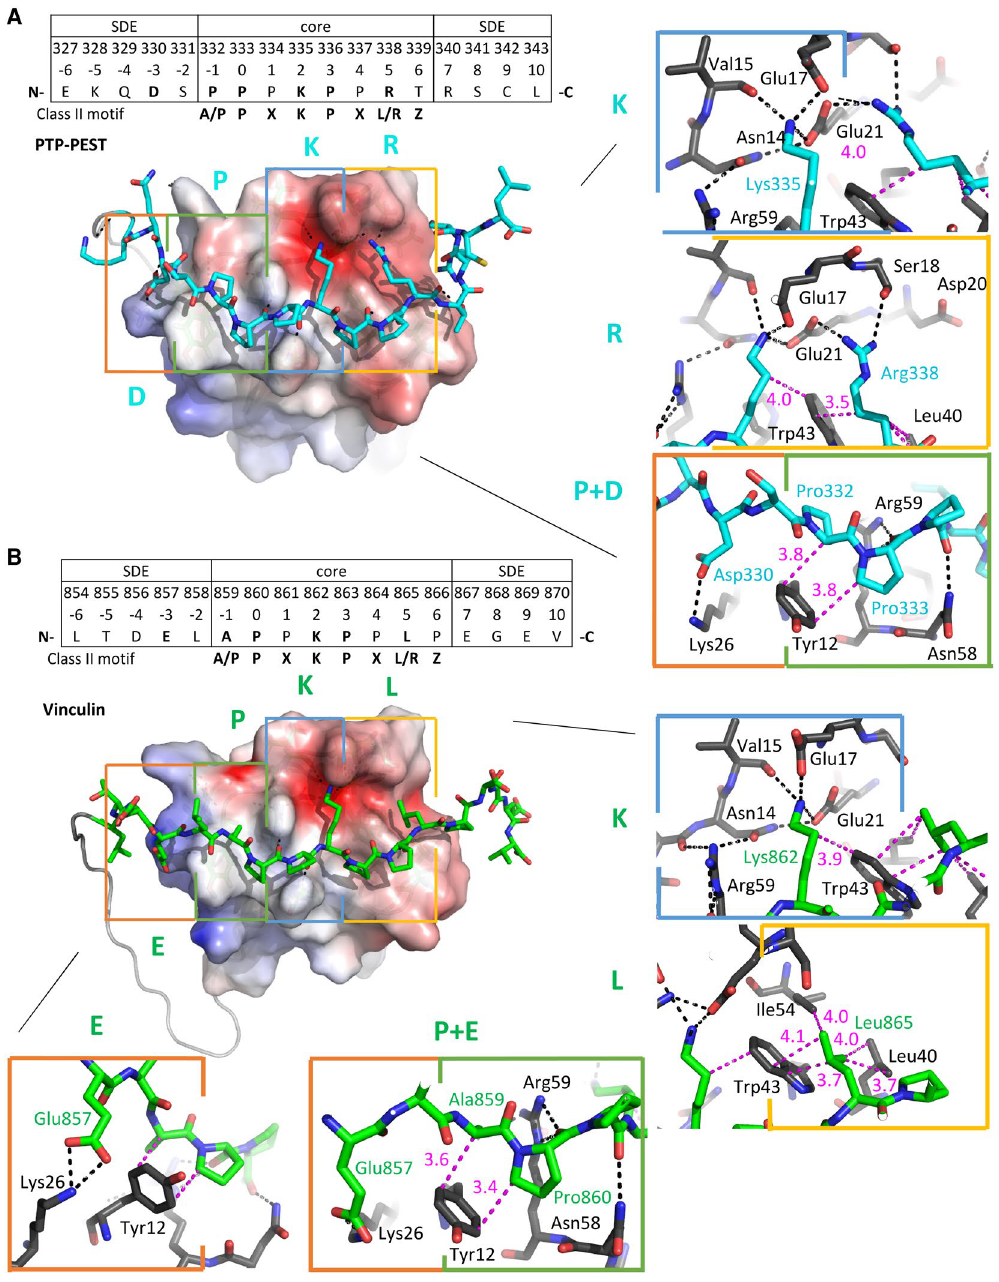
Figure 5. Key interactions between the PTP-PEST- and Vinculin- derived peptides and CAS SH3 domain. ( A ) PTP-PEST- and ( B ) Vinculin-derived peptides are shown in stick representation. The CAS SH3 parts of the complexes are shown by electrostatic potential surface representation (APBS). Four binding pockets are highlighted with rectangles (orange - zero pocket/upstream SDE, green - 1st pocket, blue - 2nd pocket, yellow - 3rd pocket), and the interaction interface is shown on the right in detail (PTP-PEST in cyan, Vinculin in green, CAS SH3 in gray). Capital letters E/D, P, K, L/R represent the key ligand amino acid residue in each CAS SH3 binding pocket. The distances between a pair of residues involved in hydrophobic interaction are shown in pink; hydrogen bonds are represented by black dotted